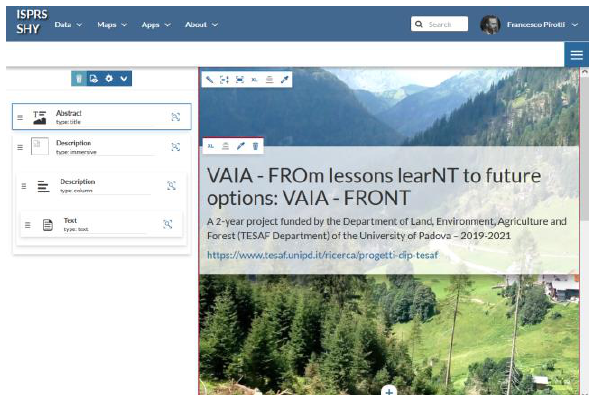
Figure 8. Example of a Geostory related to the VAIA-FRONT